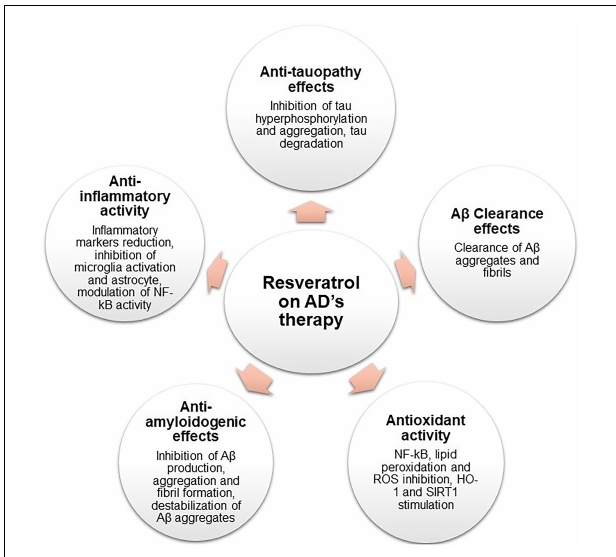
FIGURE 2 | Schematic representation of RES pharmacological activities on AD